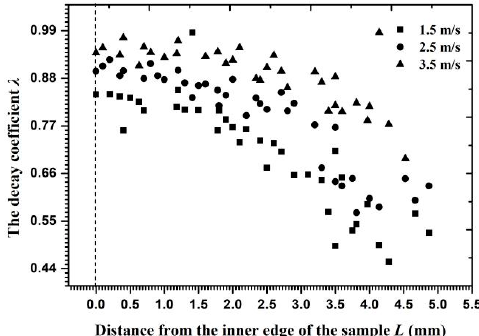
Figure 17. The velocity decay coefficient versus the distance from the inner edge at different flow velocities.